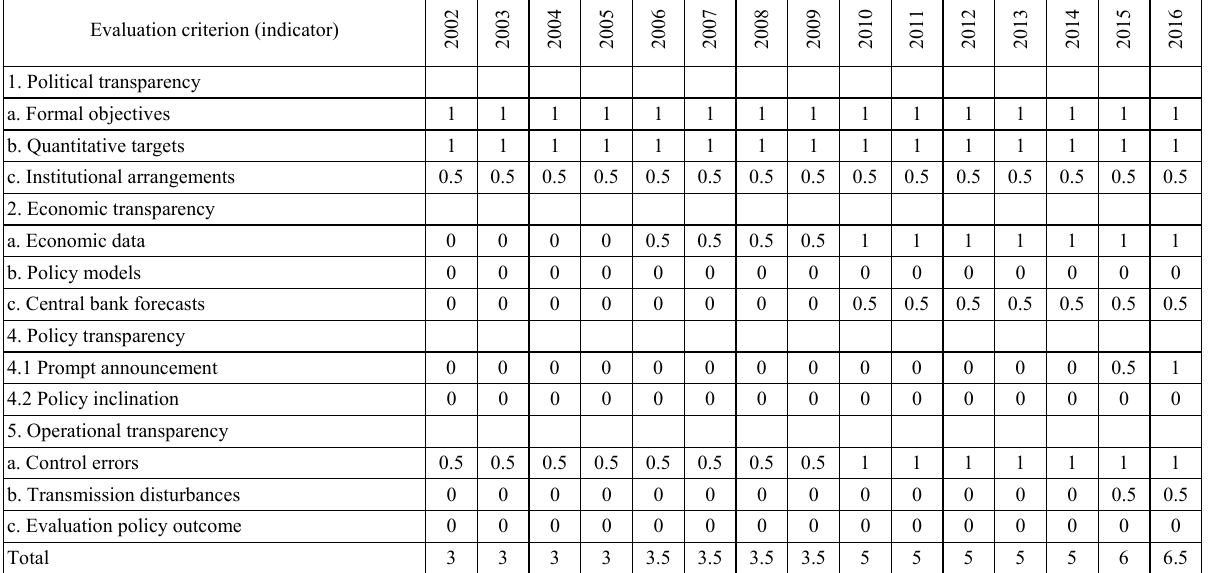
Table 1. The level of monetary policy transparency of the National Bank of Ukraine (simplified